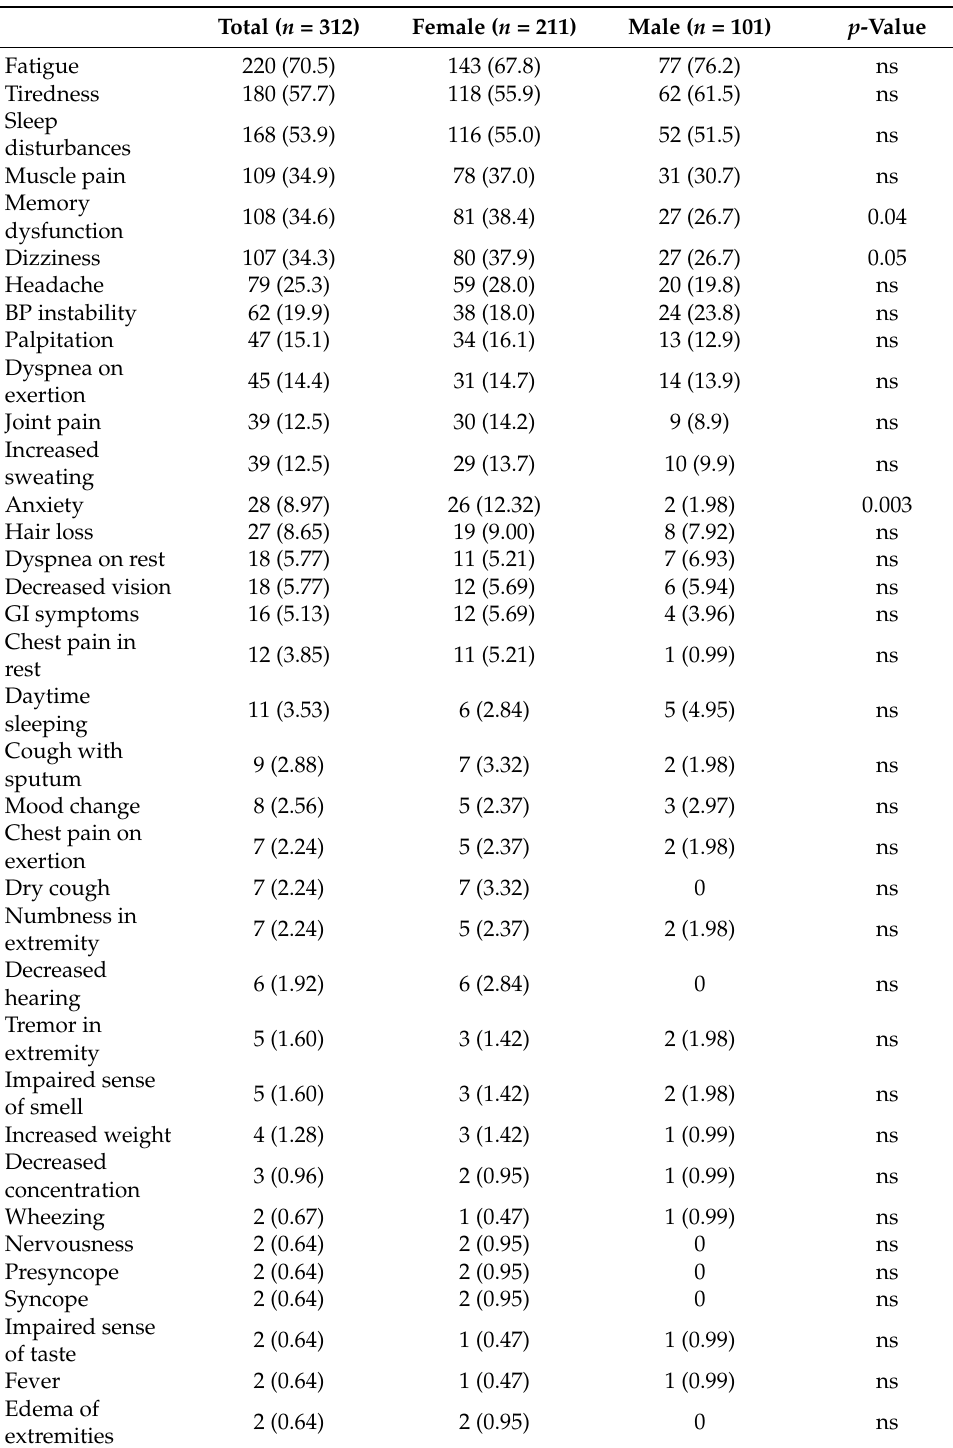
Table 2. Participant-reported clinical manifestations persistent after COVID-19 infection at median of 6 months